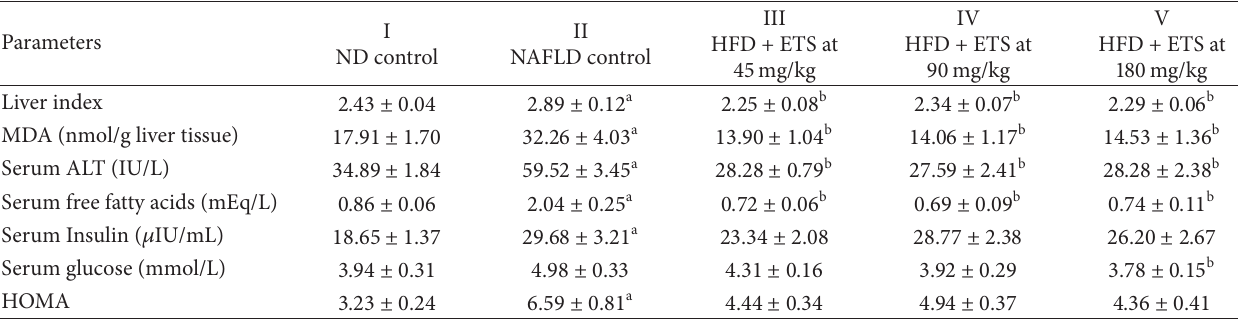
Liver index = (absolute liver weight/Body weight) ∗ 100. ETS: extract of Tamarindus indica seed coat; NAFLD: non-alcoholic fatty liver disease; ND: normal diet; HFD: high fat diet; MDA: malondialdehyde; ALT: alanine aminotransferase; HOMA: homeostatic model